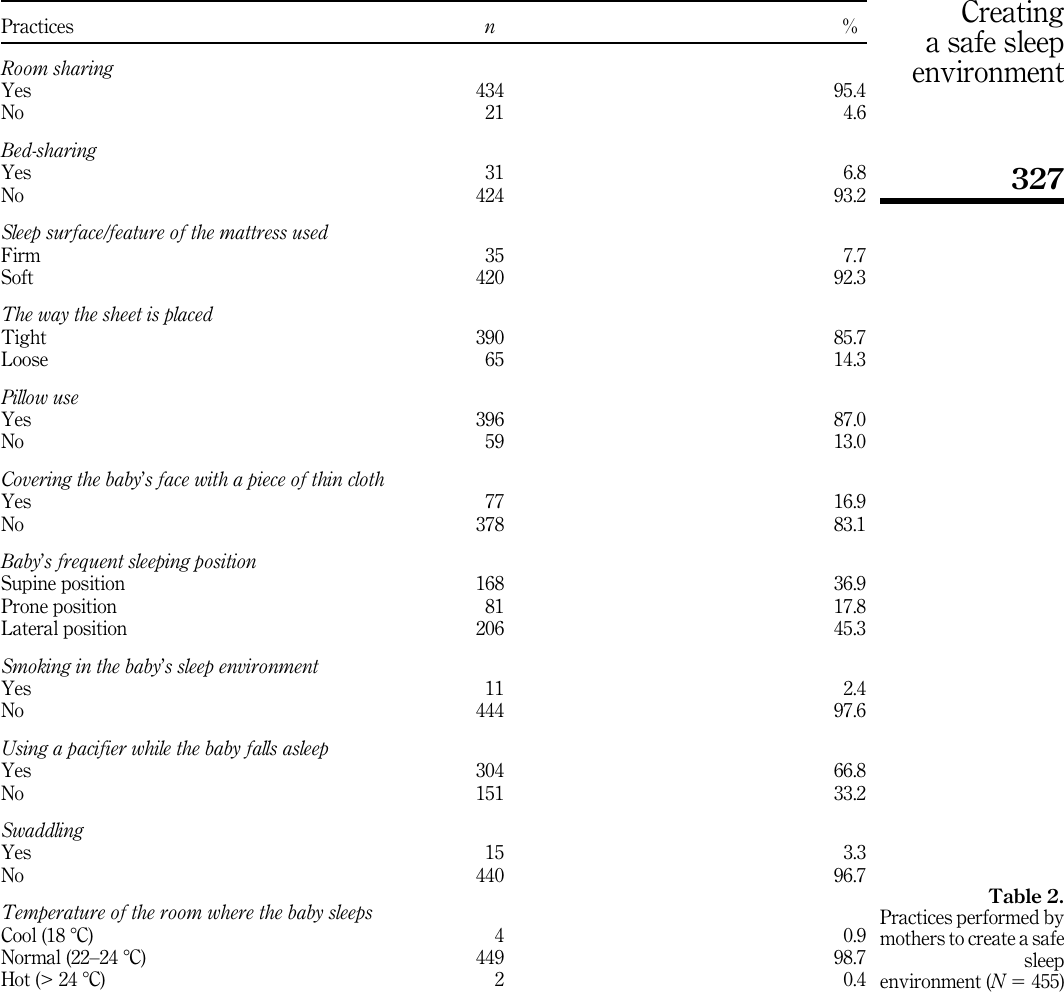
Table 2. Practices performed